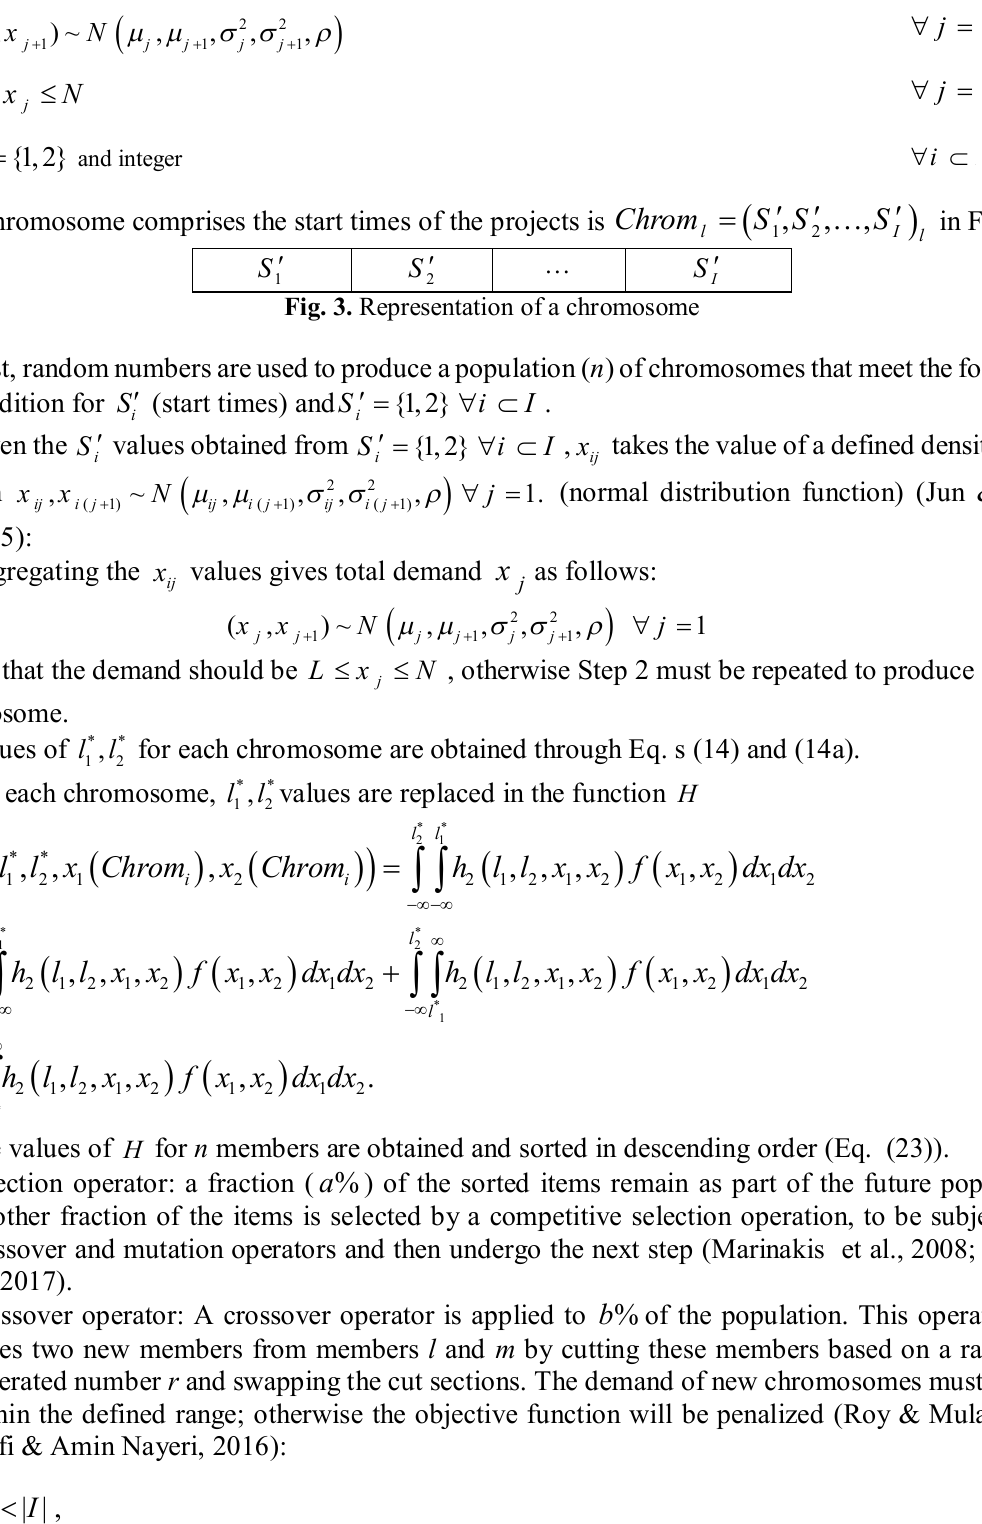
Fig. 3. Representation of a chromosome